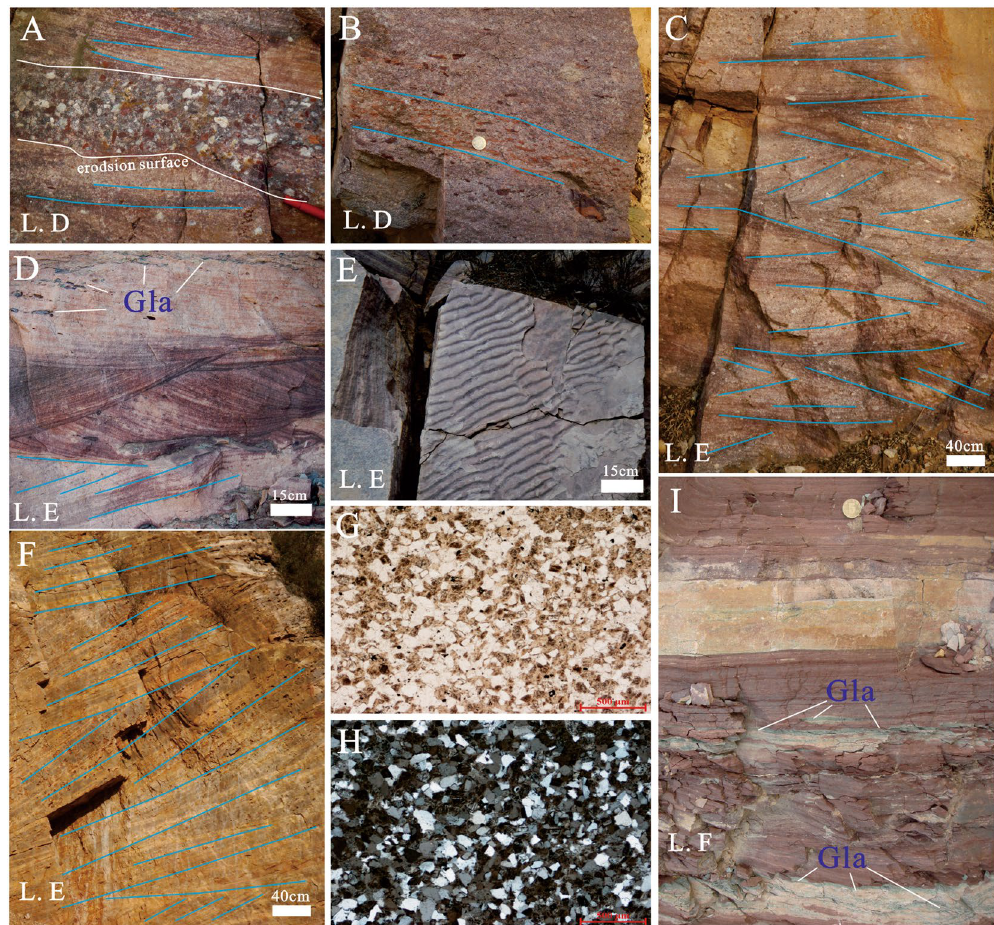
Figure 5. Outcrop and microscopic characteristics of Bingmagou Formation rock in the Mianchi and Shaoyuan regions. ( A ) Coarse sandstone interbedded with conglomerate; gravel clasts in the conglomerate are complex in composition (mainly quartz and muddy gravel), generally small and well rounded, but the muddy gravel clasts are moderately rounded. ( B ) Coarse sandstone with gravel; the gravel clasts are complex in composition but are mainly muddy gravels arranged directionally with the long axis parallel to the scoured surface. ( C ) Coarse sandstone with gravel and cross-bedding in the Shaoyuan region. ( D ) Fine-to-medium sandstone in the Mianchi region, with trough cross bedding, parallel bedding, and glauconite in the upper part (Gla = glauconite). ( E ) Fine sandstone in the Lushan region, with tuning fork-shaped ripple marks on sandstone surfaces. (F) Fine-to-medium sandstone in the Mianchi region, with low-angle swash bedding. ( G and H ) Microscopic characteristics of shoreface sandstone in the Shaoyuan region; the sandstone is rich in quartz, high in maturity, well sorted, with sub-rounded and rounded quartz grains. ( I ) Red sandy mudstone with thin siltstone interbeds and layered or lenticular